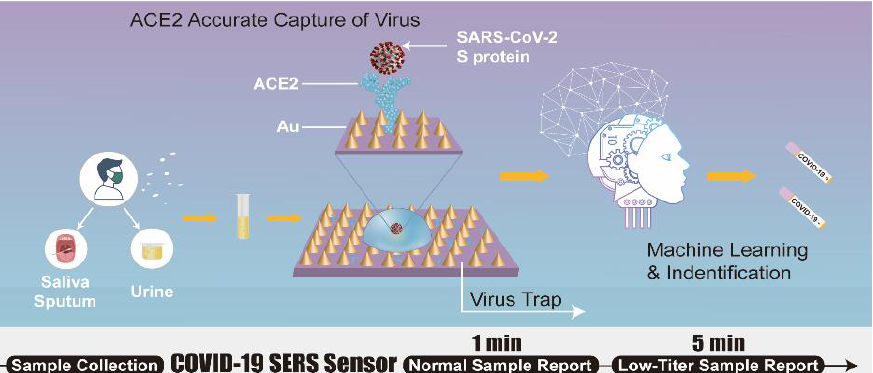
Figure 10. Schematic of SERS biosensor based on ACE2 for SARS-CoV-2 detection. Adapted from